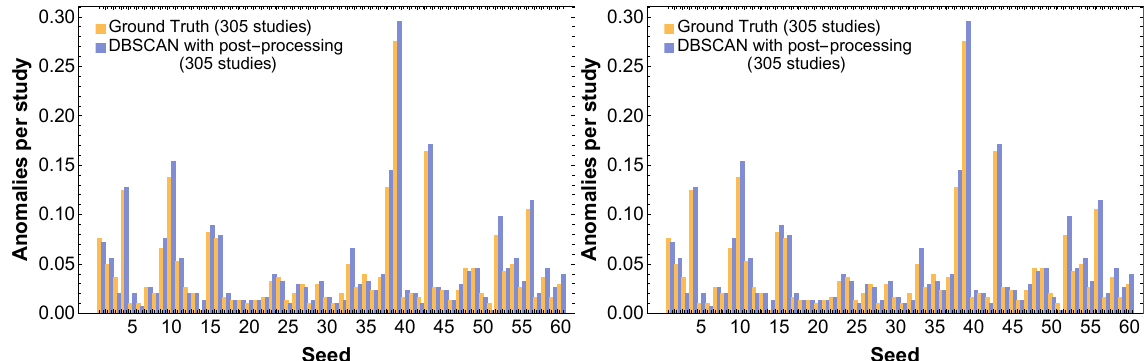
Figure 6. Visualizations of the anomalies by seed ( left ) and by angle ( right ), showing the similarity between the ground-truth and the result of the post-processing following